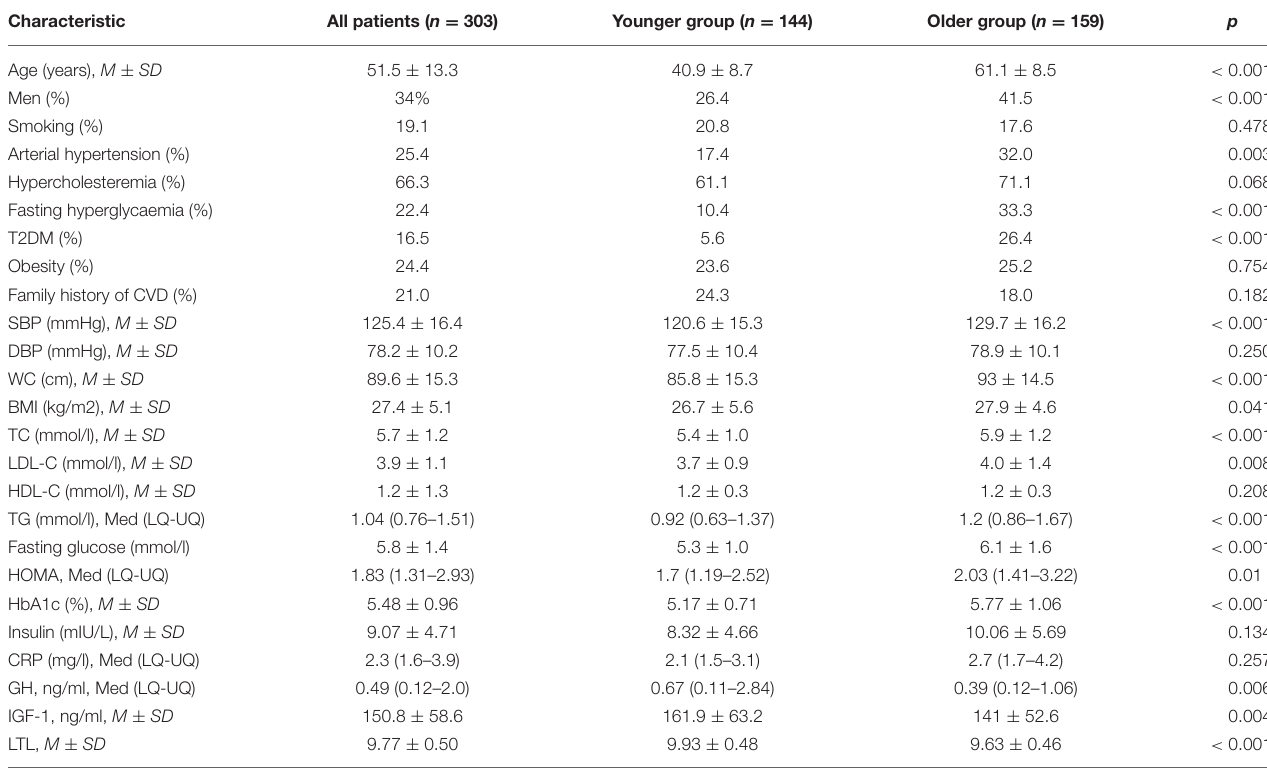
TABLE 1 | Characteristics of the patients included in the study ( n = 303). Characteristic